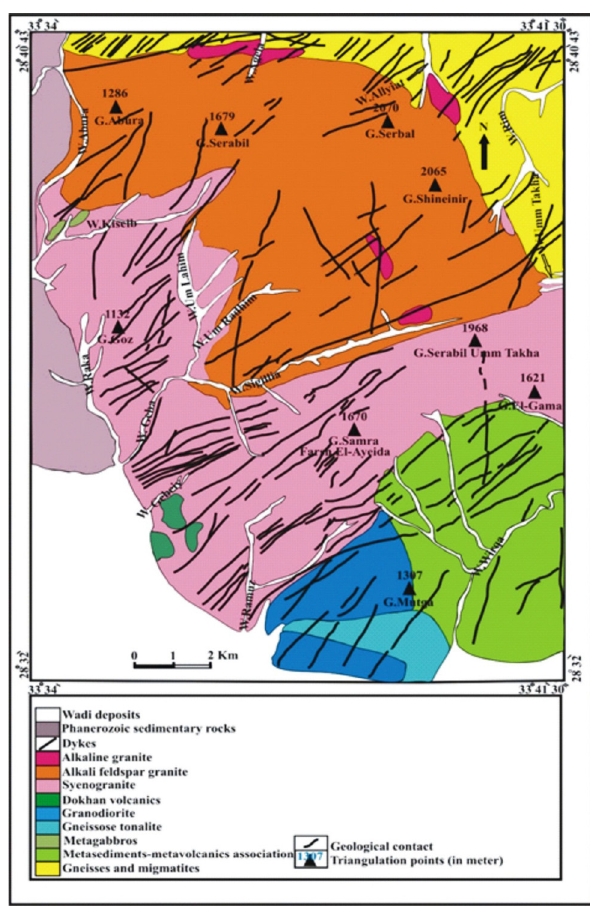
Figure 1: Distribution map of dikes traversing the rock varieties in the G. Serbal area, Southwestern Sinai, Egypt ( Kamar [ 19 ])